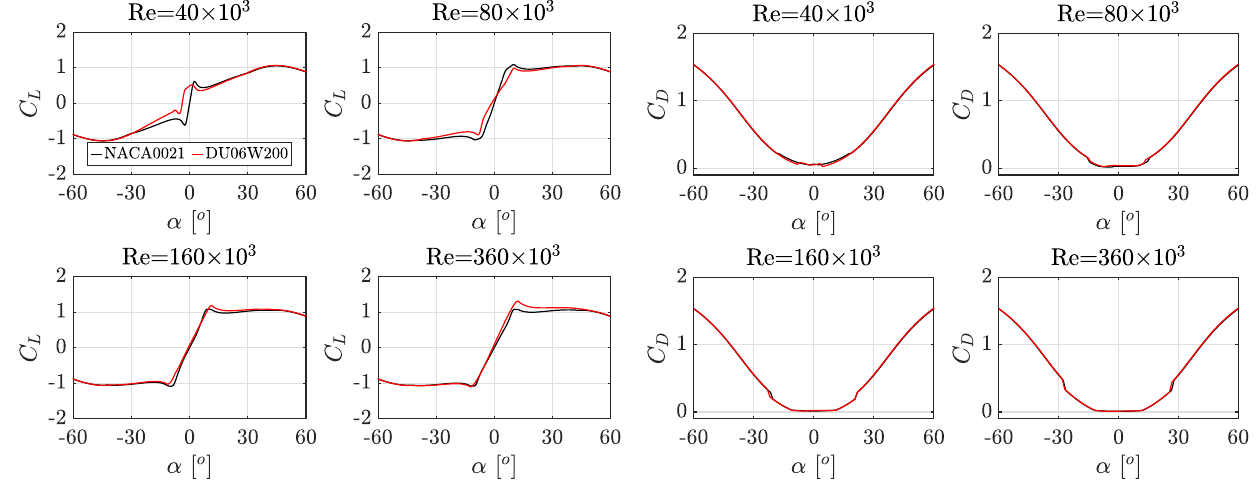
Figure 2. Lift and drag coefficients of NACA0021 and DU06W200 at low